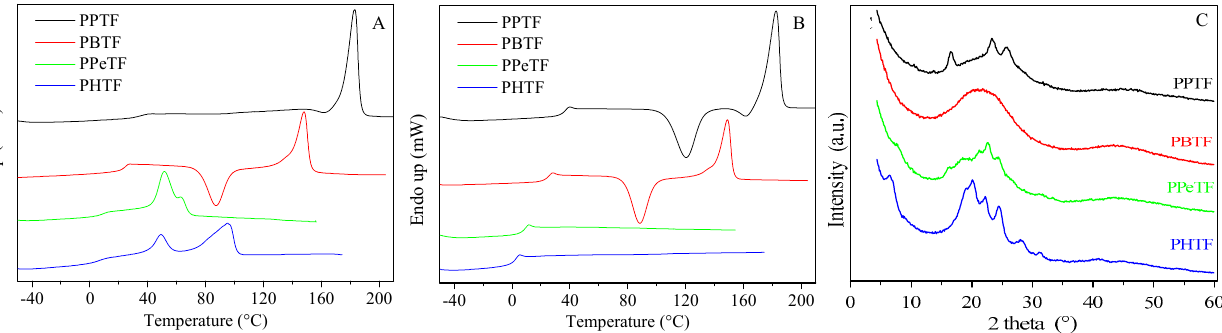
Figure 4. ( A ) TGA curves and ( B ) TGA derivatives of PPTF, PBTF, PPeTF and PHTF homopolymers; ( C ) comparison between T onset of both thiophene- and furan-based homopolymers.